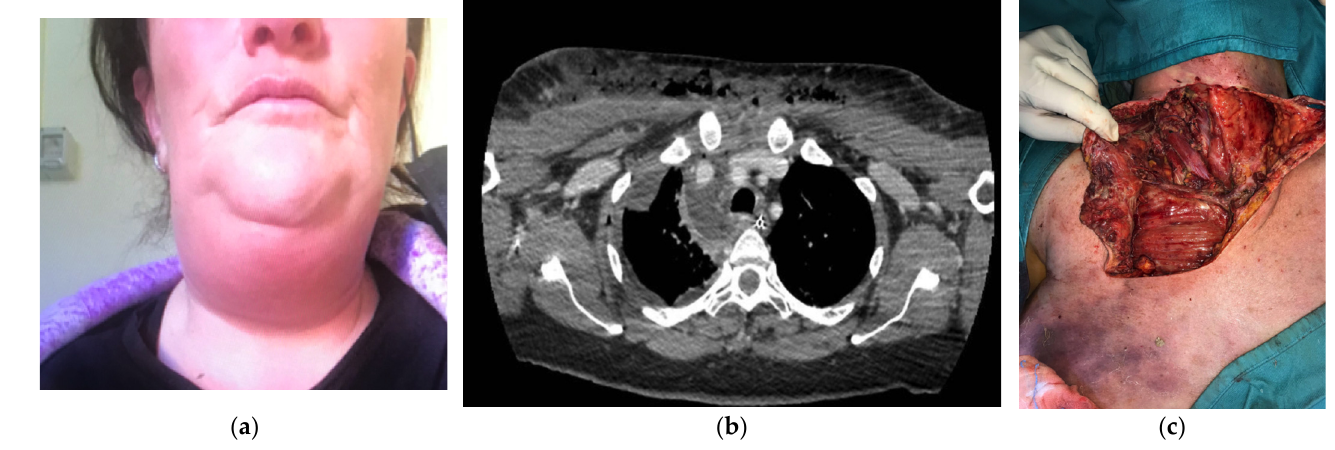
Figure 1. ( a ) A 48-year-old woman with cervical swelling and odynophagia. ( b ) A preoperative computed tomography scan showing the spread of infection extending to the lower anterior medi- astinum, below the tracheal bifurcation with associated right pleural effusion. ( c ) Ample cervicotomy extended to the anterior pectoral exposition for a cervico-thoracic deep infection.